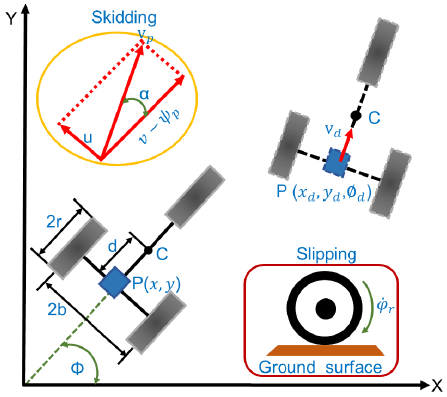
Figure 1. Schematic diagram of the mobile